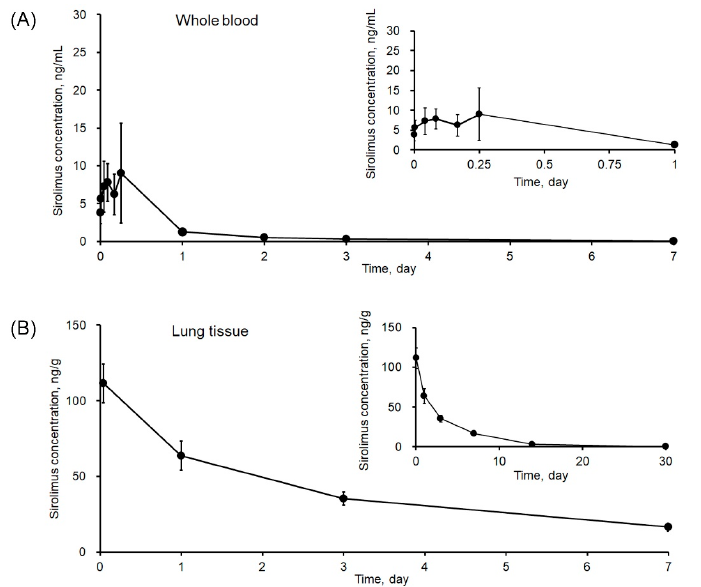
Figure 4. Sirolimus concentration–time profiles in ( A ) porcine whole blood ( n = 12–24) and ( B ) lung tissue ( n = 3) following the application of a stent device containing sirolimus. The insets show sirolimus concentration–time profiles within 1 day for whole blood and 30 days for lung tissue. Table 6. Summary of pharmacokinetic parameters in whole blood for sirolimus ( n = 24). PK Parameters